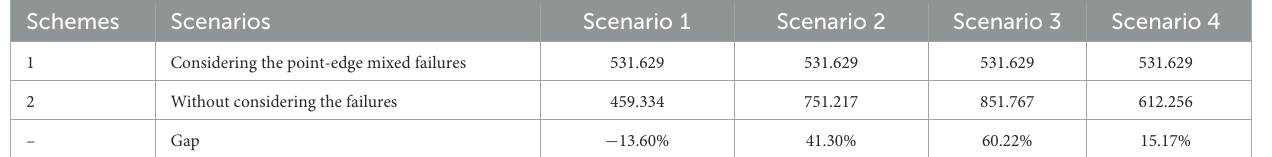
TABLE 3 Comparison of the two